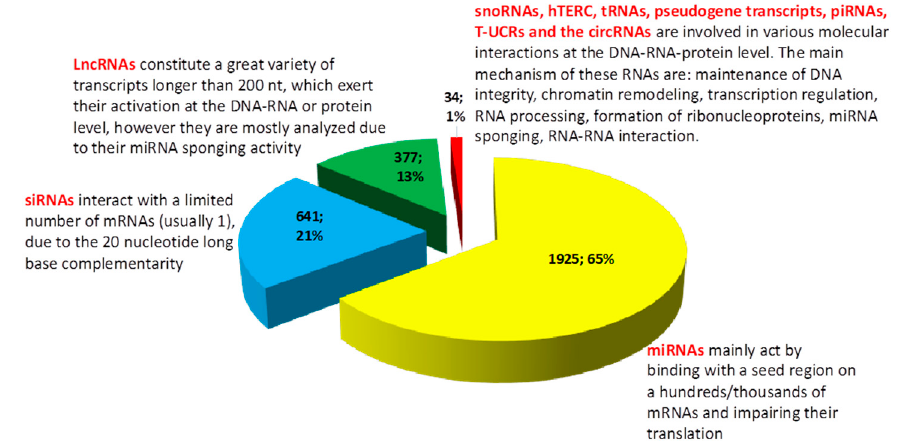
Figure 1. Graphic representation of the MeSH (PubMed comprehensive controlled vocabulary), results, by using the keywords “Lung Neoplasms” (MeSH)) and “RNA, Untranslated” (MeSH), from 5008 (date of access: 25.03.2019), we included in our brief analysis 2977 articles specific for our subject. More than 65% of studies (meaning 1925 articles from a total of 2977 investigated articles (based on MeSH vocabulary, “Lung Neoplasms” [Mesh] AND “RNA, Untranslated” [Mesh]), including original articles, reviews, and meta-analysis) analyzed the implication of various miRNAs in lung cancer (excluding studies which included the axis lncRNAs-miRNAs-mRNAs). At the same time, 21% of the current literature (meaning 641 articles from a total of 2977 investigated articles, including original articles, reviews and meta-analysis) have included siRNAs as a therapeutic option (from the total number of siRNAs studies we excluded the ones who had as their main subject the study of miRNAs). The “classic” lncRNAs (which includes a high heterogeneity of transcripts) are on the third place, comprising 13% of the total number of studies (377 out of 2977). CircRNAs are in the fourth place, but their number has continuously increased over the last year (20 studies from 2977). The lesser studied non-coding RNAs (snoRNAs, hTERC, tRNAs, piRNAs, pseudogene transcripts and T-UCRs) comprise only 0.47% of articles which analyze the role of non-coding RNAs in lung cancer; however, they are involved in various and multi-level molecular processes.